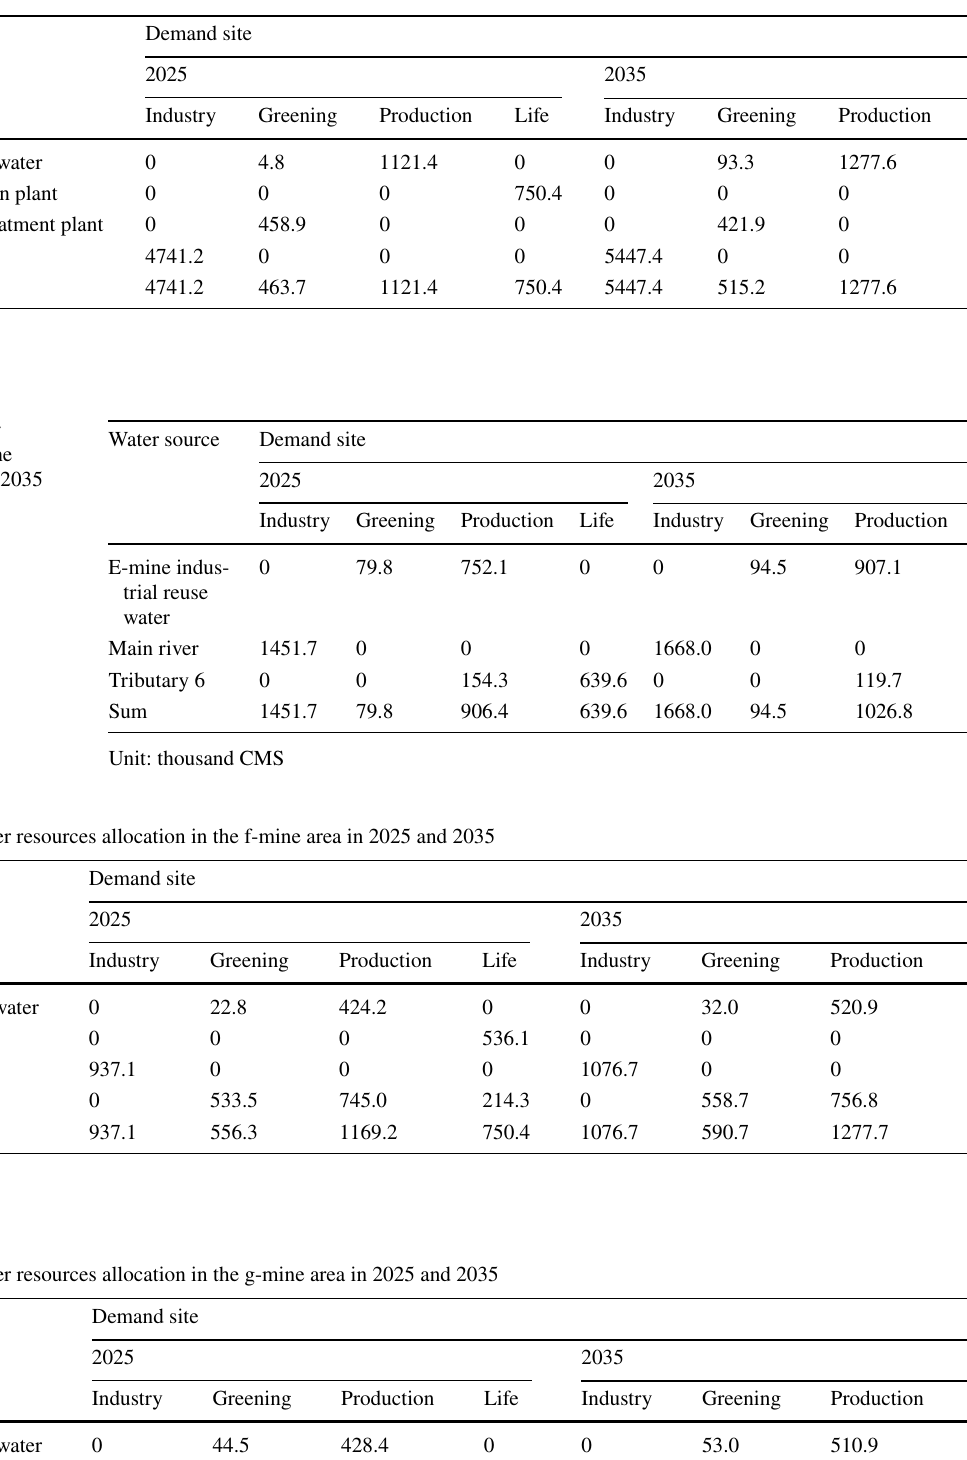
Table 8 Results of water resources allocation in the d-mine area in 2025 and 2035